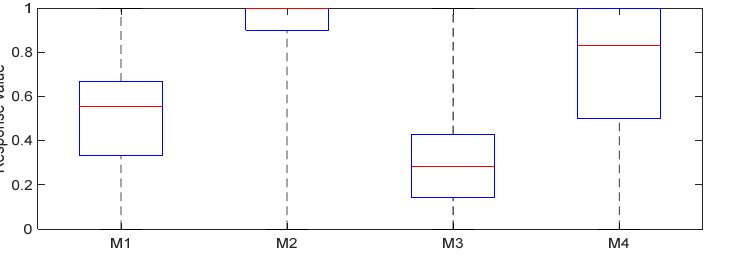
Figure 1. Statistics of respondents’ answers for individual modules: median, quantiles, minimum, and maximum value.